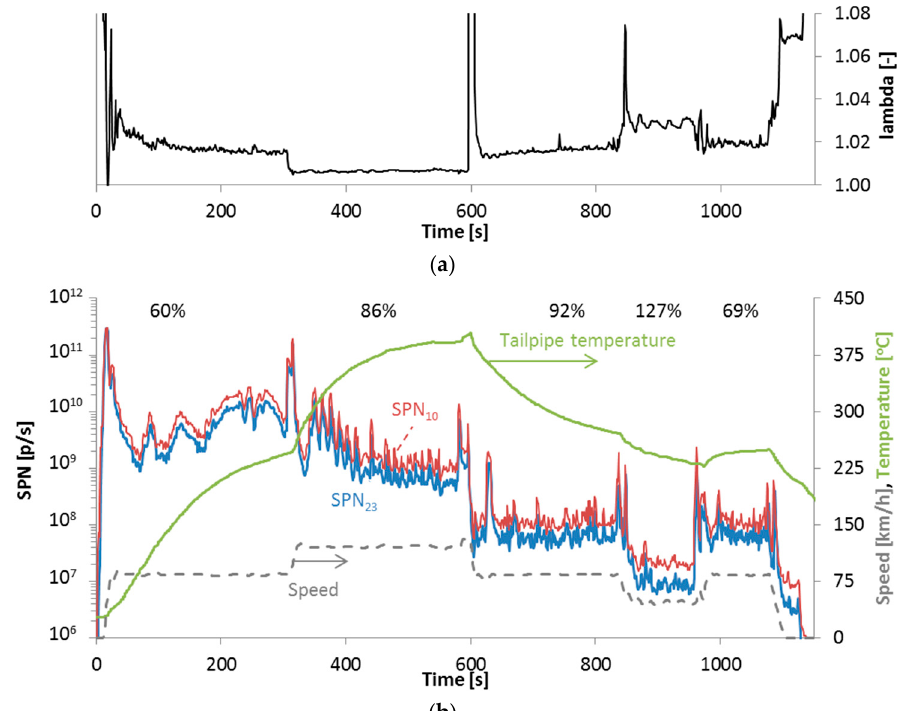
Figure 8. ( a ) Lambda; ( b ) solid particle number (SPN) emissions > 23 nm and > 10 nm measured at the tailpipe for L3e-A3 #8. Percentages give the additional particles < 23 nm. Speed and exhaust gas temperature are also shown.